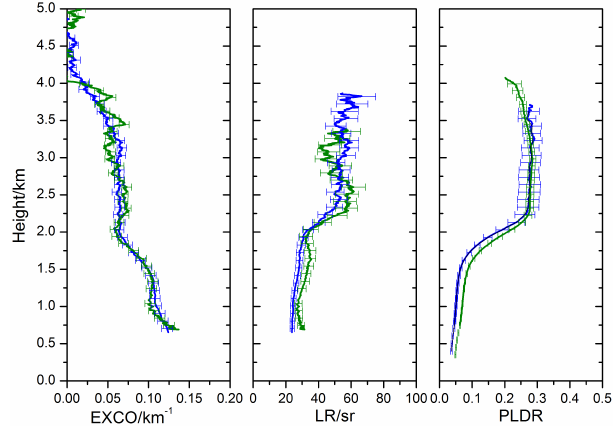
Figure 7. Same as Fig. 5 but for 27 June 2013, 00:00–02:00UTC.